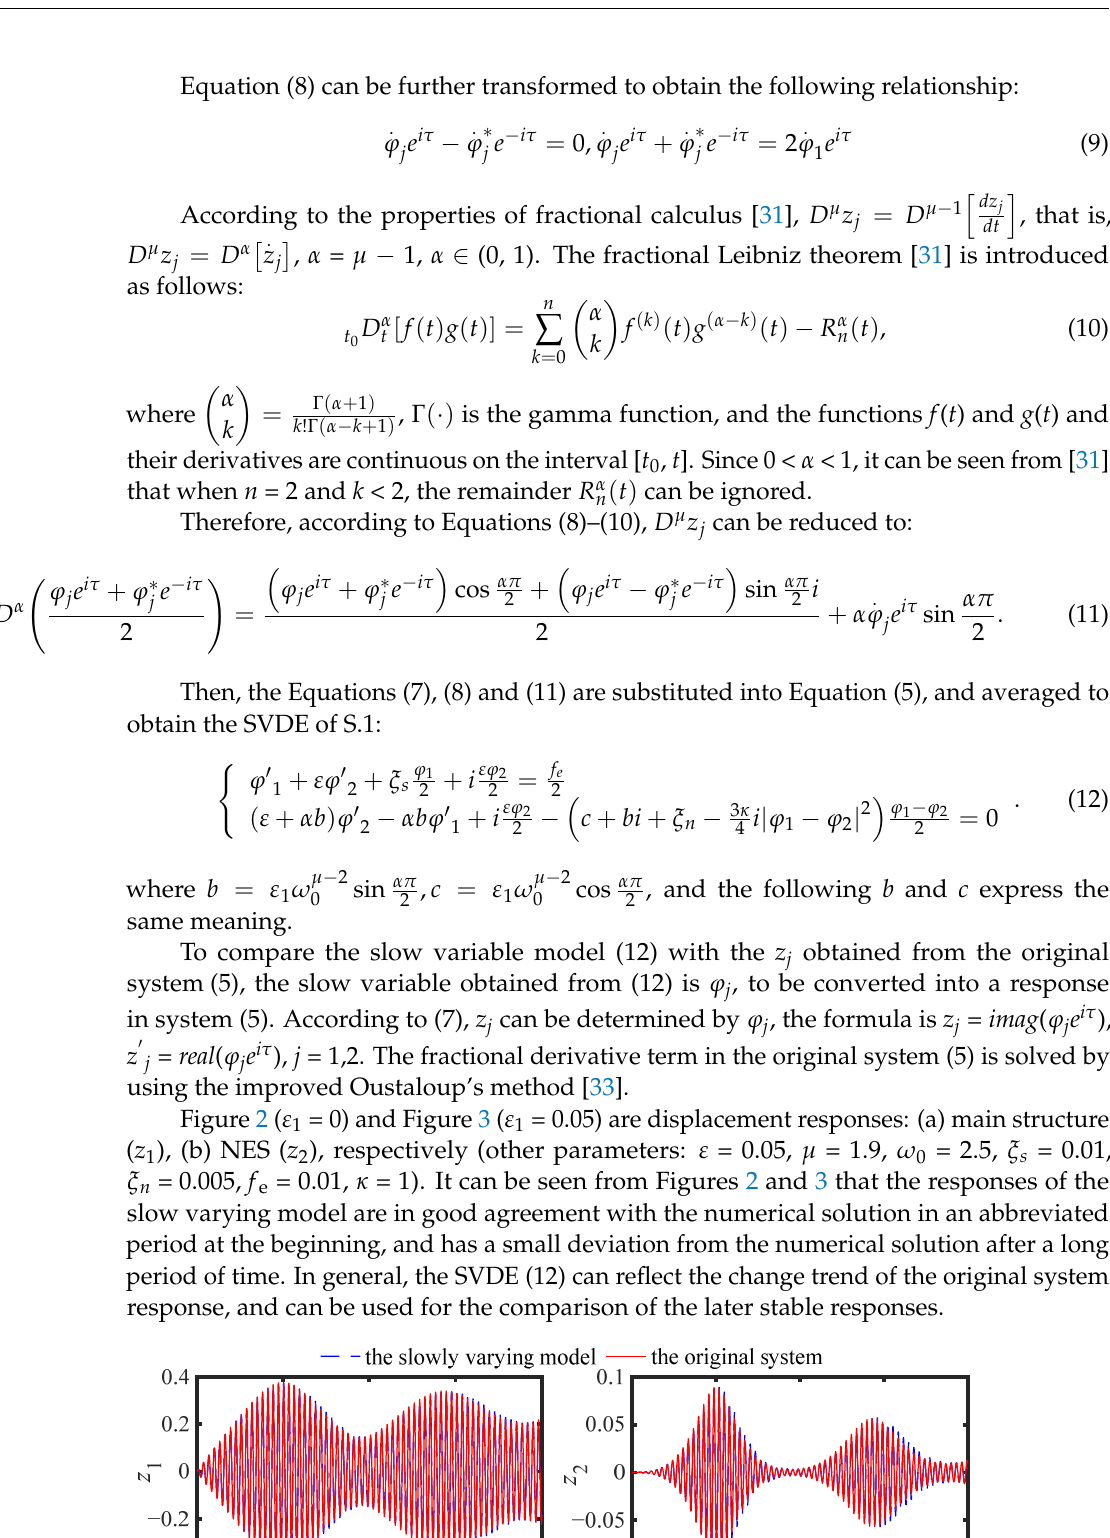
( b ) Figure 3. Displacement responses: ( a ) main structure, ( b ) NES ( ε 1 = 0.05). 3.2. The Discriminant Derivation of the Number of Equilibrium Points of S.1 To discuss the steady-state characteristics of the SVDE (S.1), it is difficult to calculate the equilibrium point of Equation (12) by directly making the derivative term 0. Therefore, the following variables are substituted for Equation (12): 1